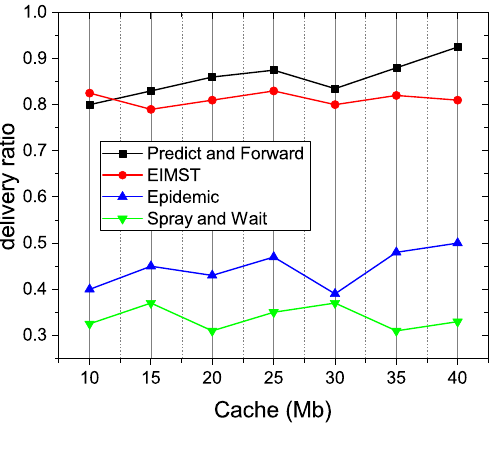
Figure 10. Delivery